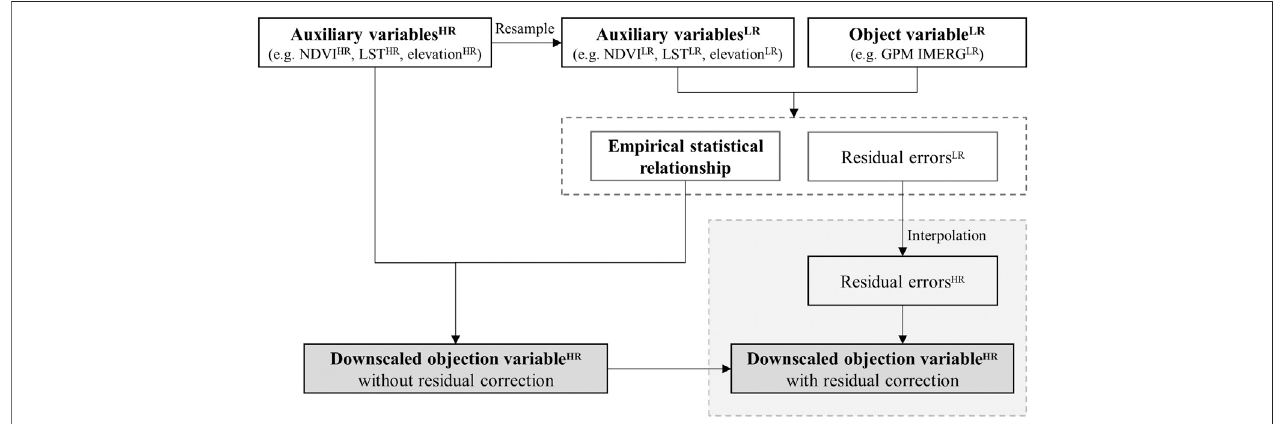
FIGURE 2 | Flowchart of the general statistical spatial downscaling procedure. The superscripts HR and LR refer to the high/ fi ne resolution and the low/coarse resolution, respectively.